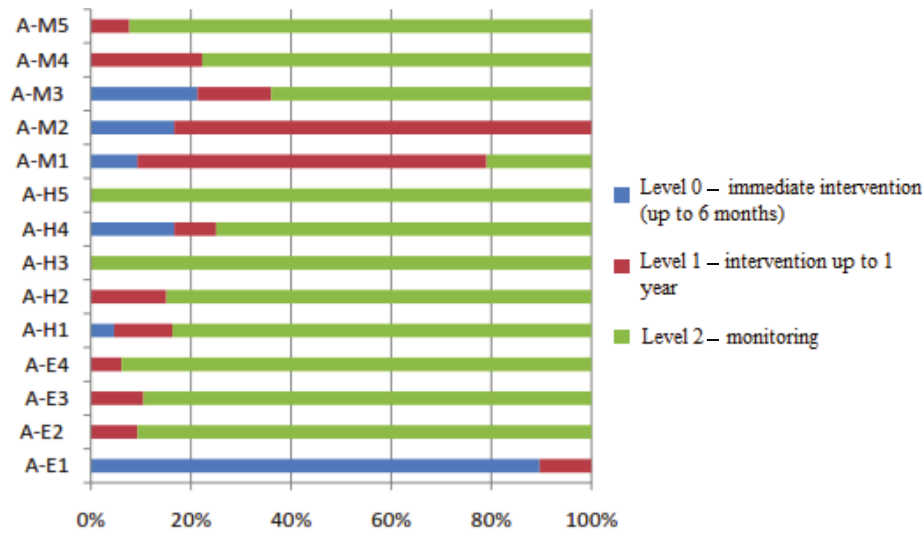
Fig. 4. Urgency to intervene/gravity of anomaly levels, according to the anomalies identified in the sample